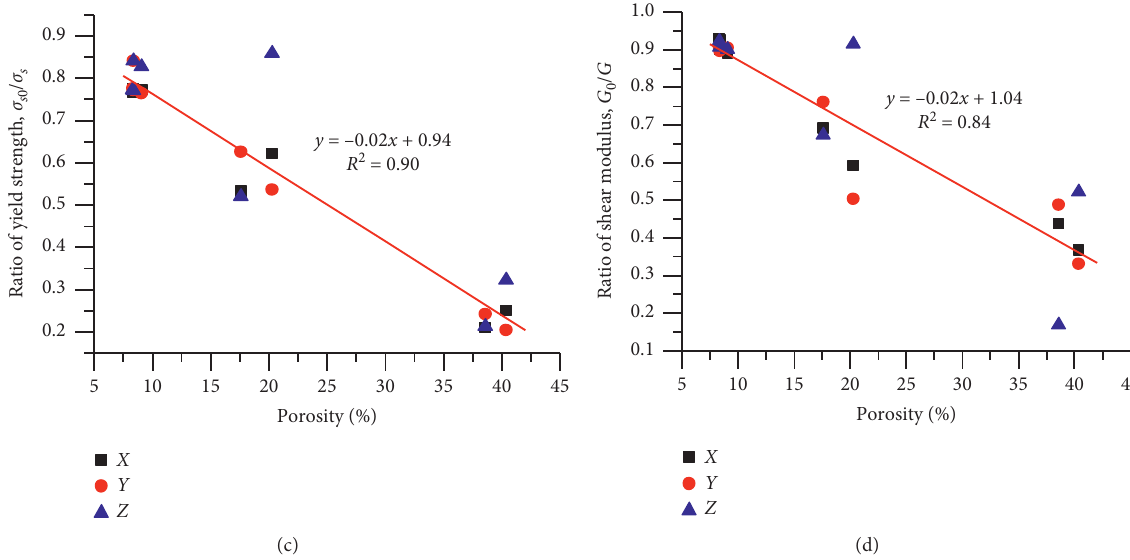
Figure 13: Correlation analysis between porosity and rock mechanics parameters. (a) ∼ (d) are the ratio of Young’s modulus, ratio of compressive strength, ratio of yield strength, and ratio of shear modulus against the model porosity for correlation analysis.